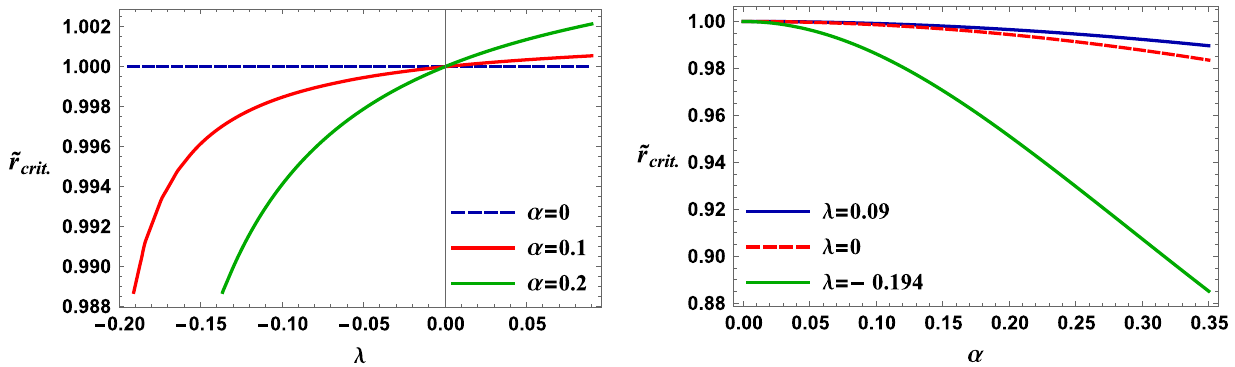
asafunctionof λ forfixedvaluesof α .Rightplot:normalizedtransitioncurve ˜ r crit . = r crit . r λ = 0 crit .